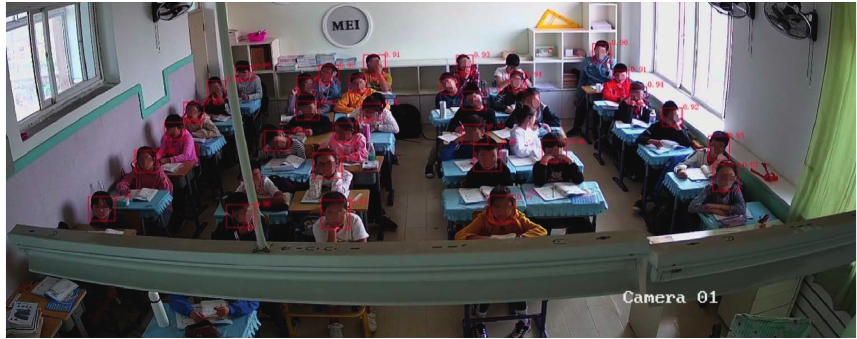
Figure 6: Example of group attentional concentration status